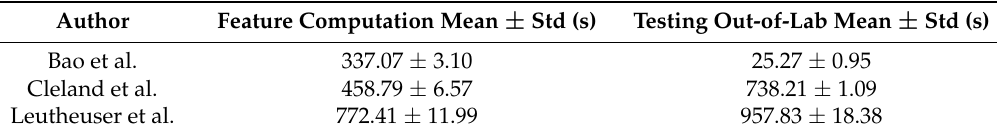
Table 8. Computational complexity in the in-lab training/out-lab testing